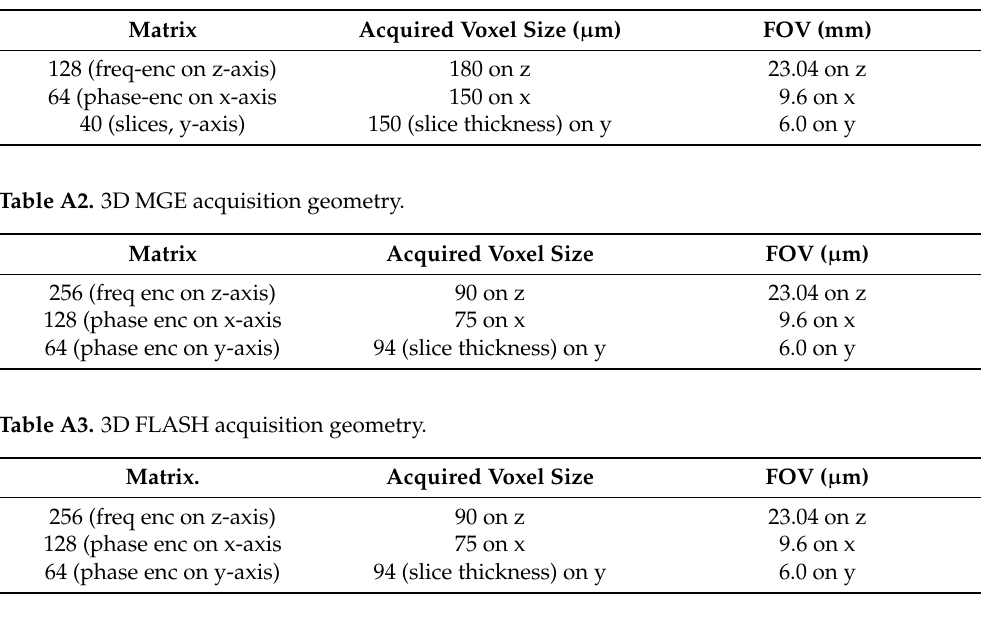
Table A1. DWI acquisition geometry.